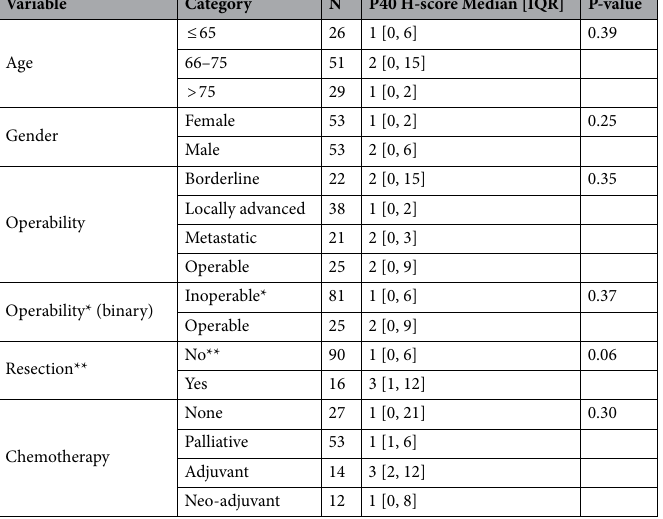
Patient group p40 H-score N Survival (months) Median (95% CI) P-value All patients (N = 106) All patients (N = 106)